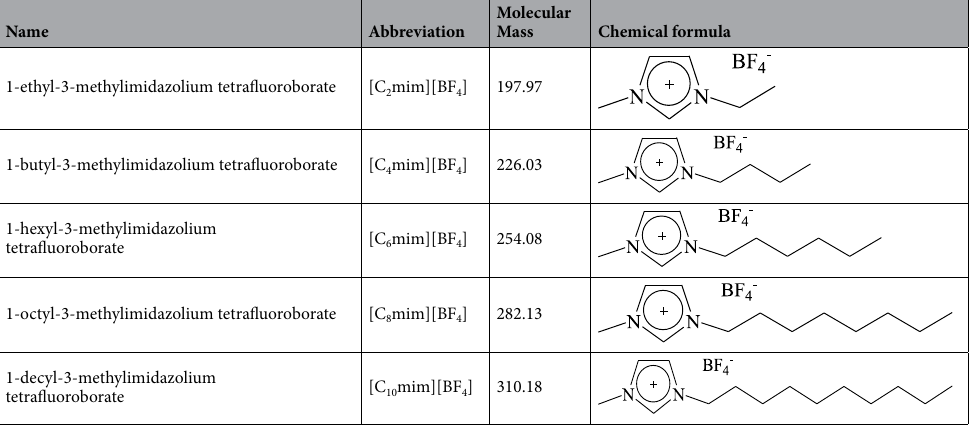
Table 3. Names, molecular mass and chemical structures of ILs